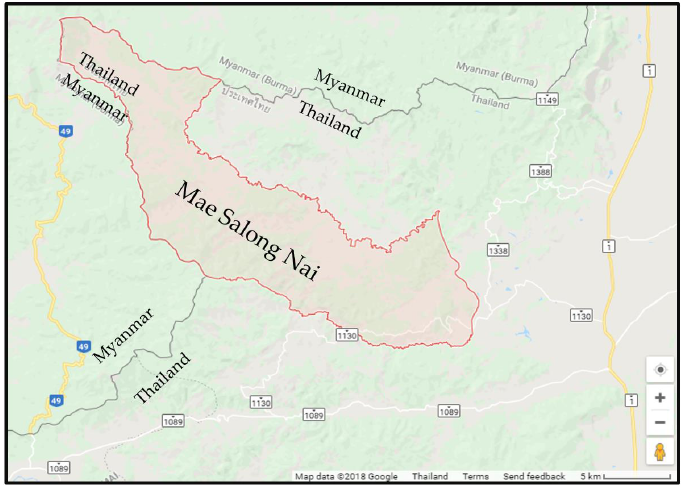
Figure 4. Map of study location, Mae Salong Nai, Chiang Rai, Thailand [19].